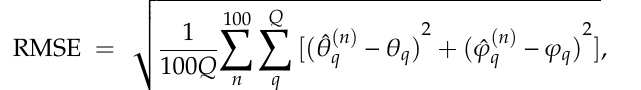
Figure 11. ( a ) The normalized spectral function derived from the MUSIC algorithm ( M = 4, K = 3);